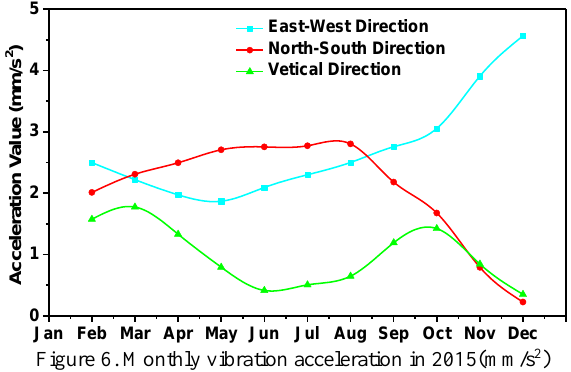
Figure 6. Monthly vibration acceleration in 2015(mm/s 2 )